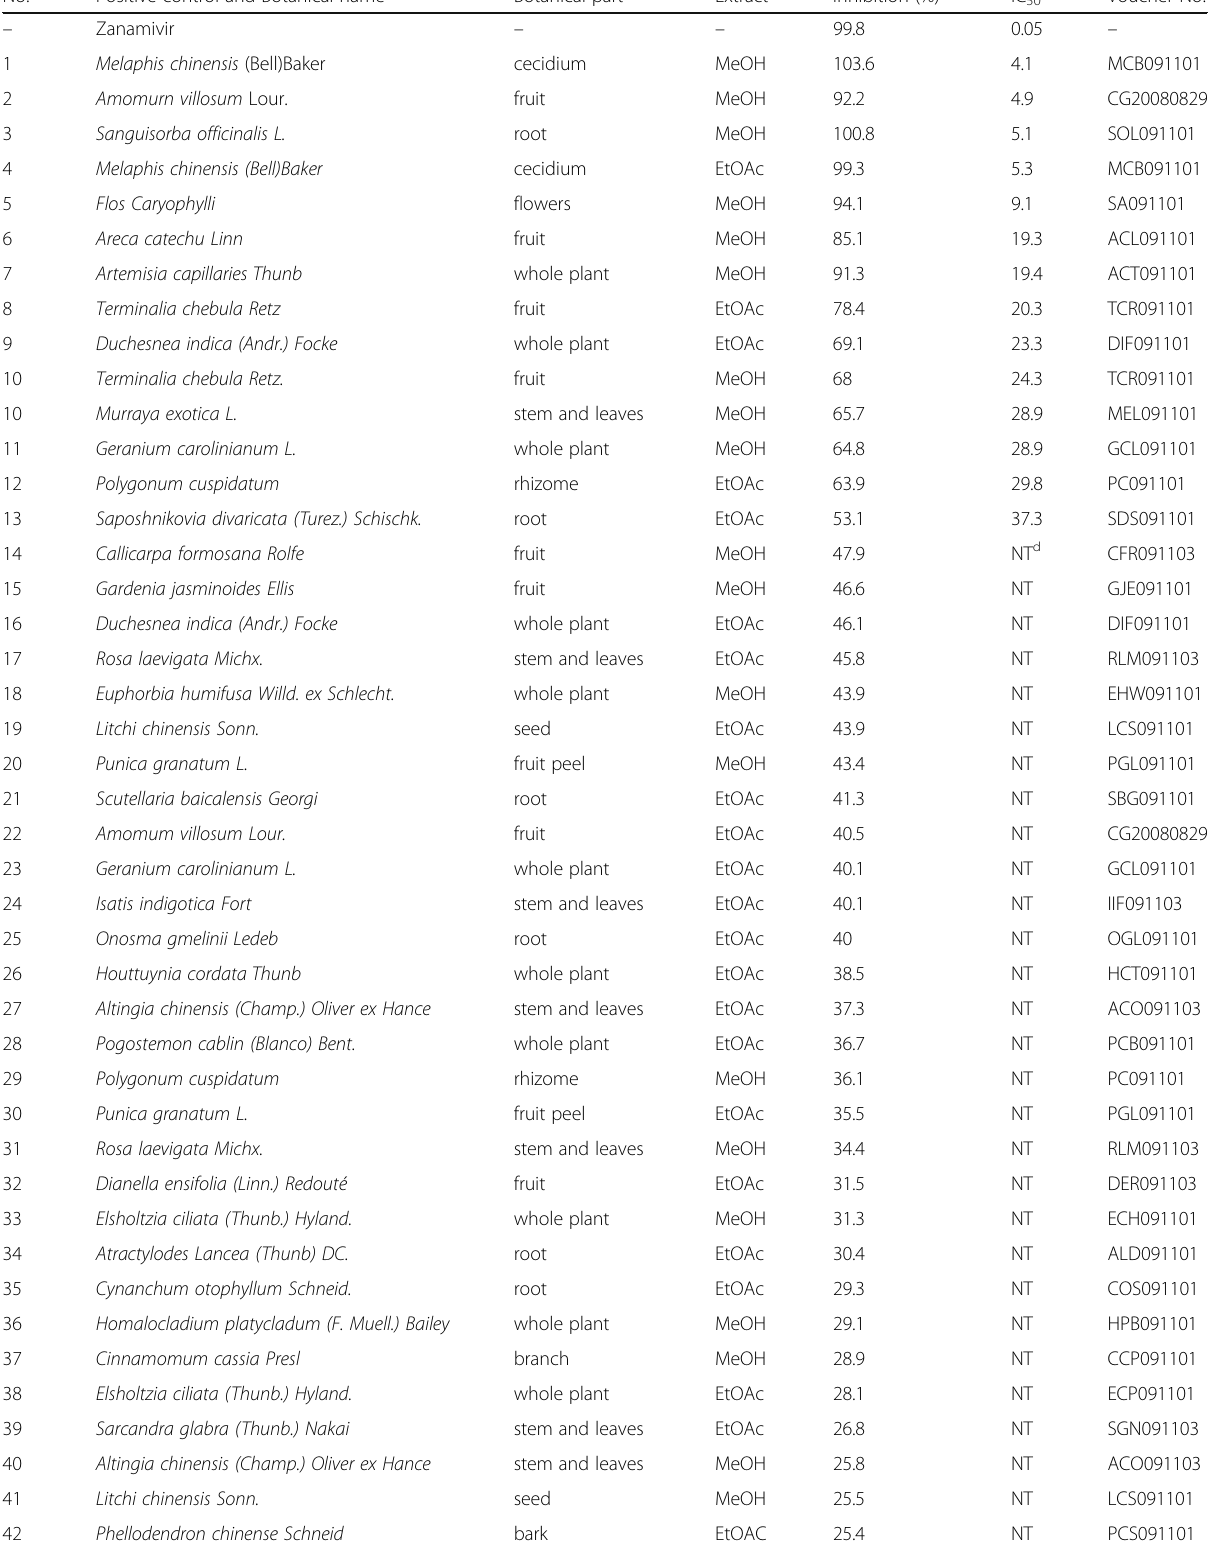
Table 1 Inhibitory activities of Chinese herbs extract on A(H1N1) influenza virus